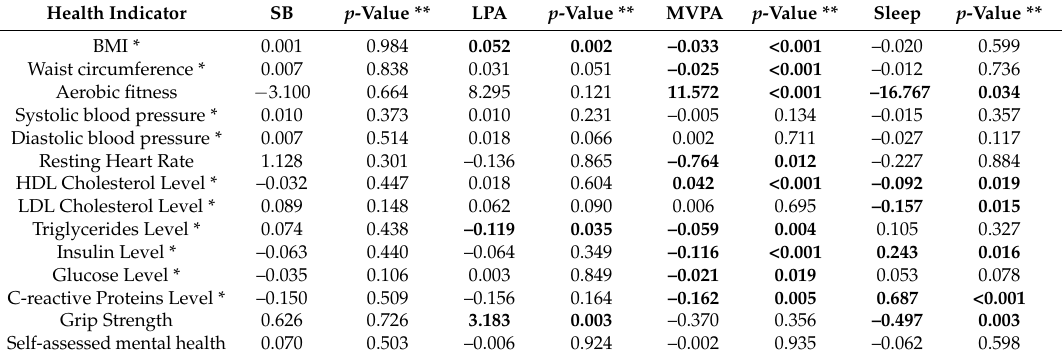
Table 1. Associations between health indicators and reallocations of time to individual components of the 24-h day from across the other components of the 24-h day for adults (18–64 years). Health Indicator SB p -Value ** LPA MVPA